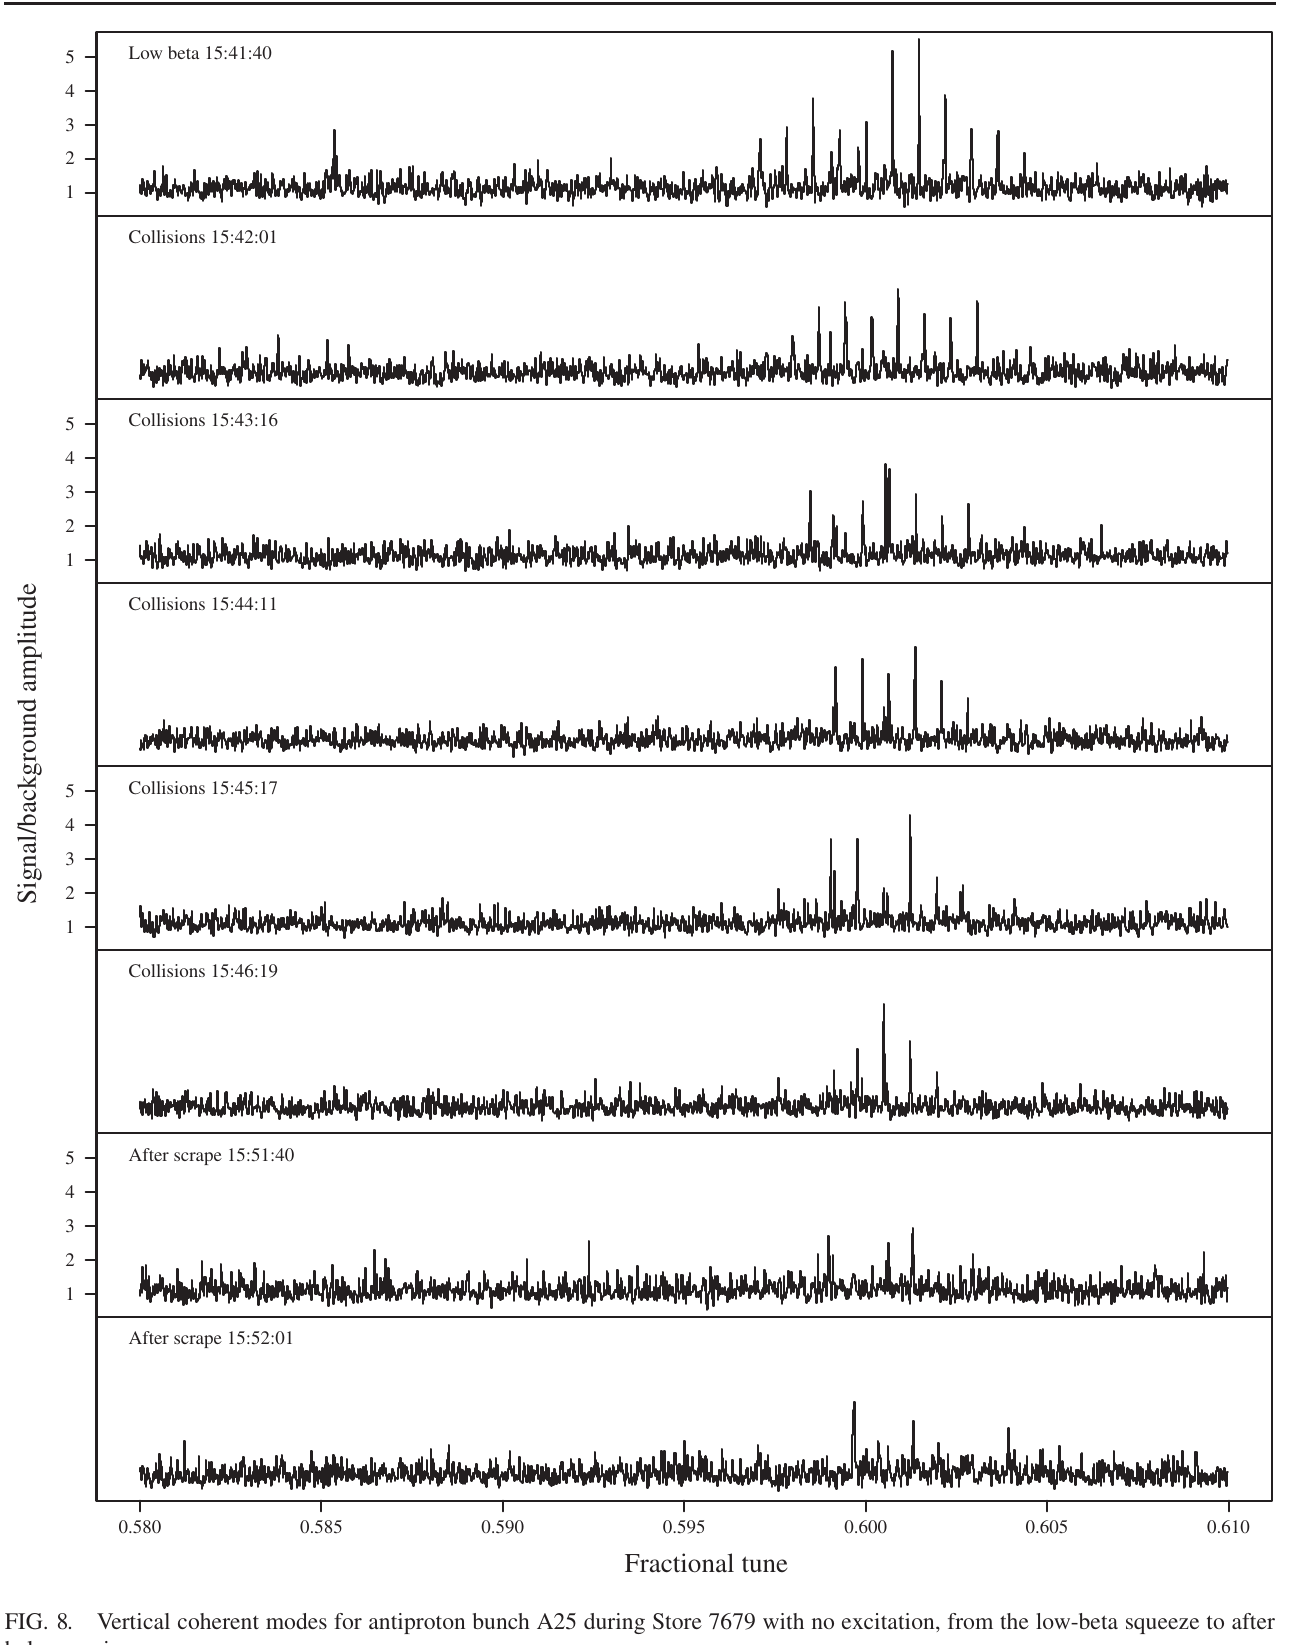
FIG. 8. Vertical coherent modes for antiproton bunch A25 during Store 7679 with no excitation, from the low-beta squeeze to after halo